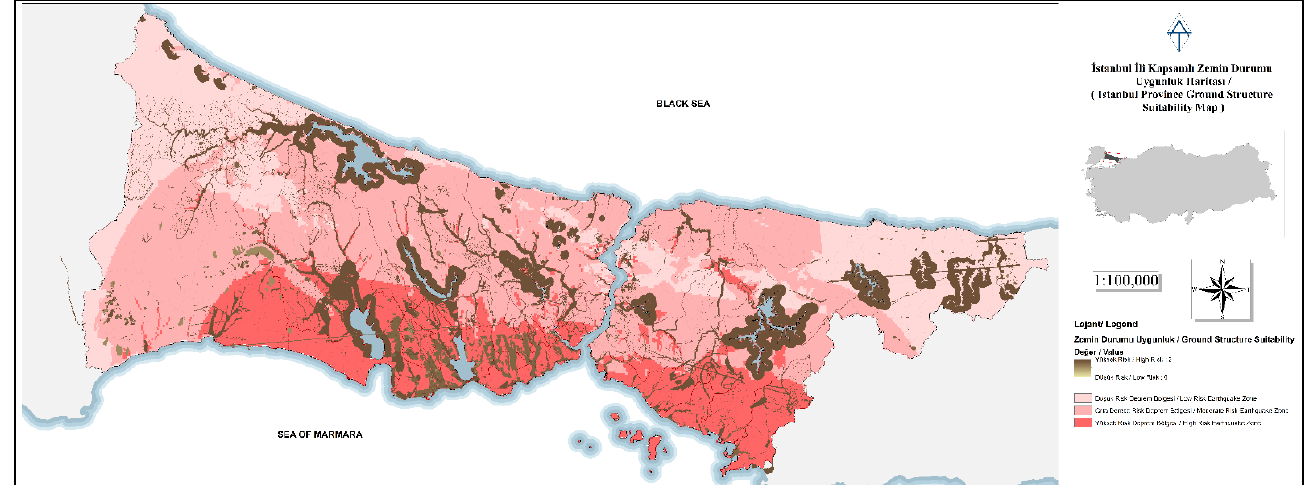
Figure 15. Istanbul Province Ground Structure Suitability Map.